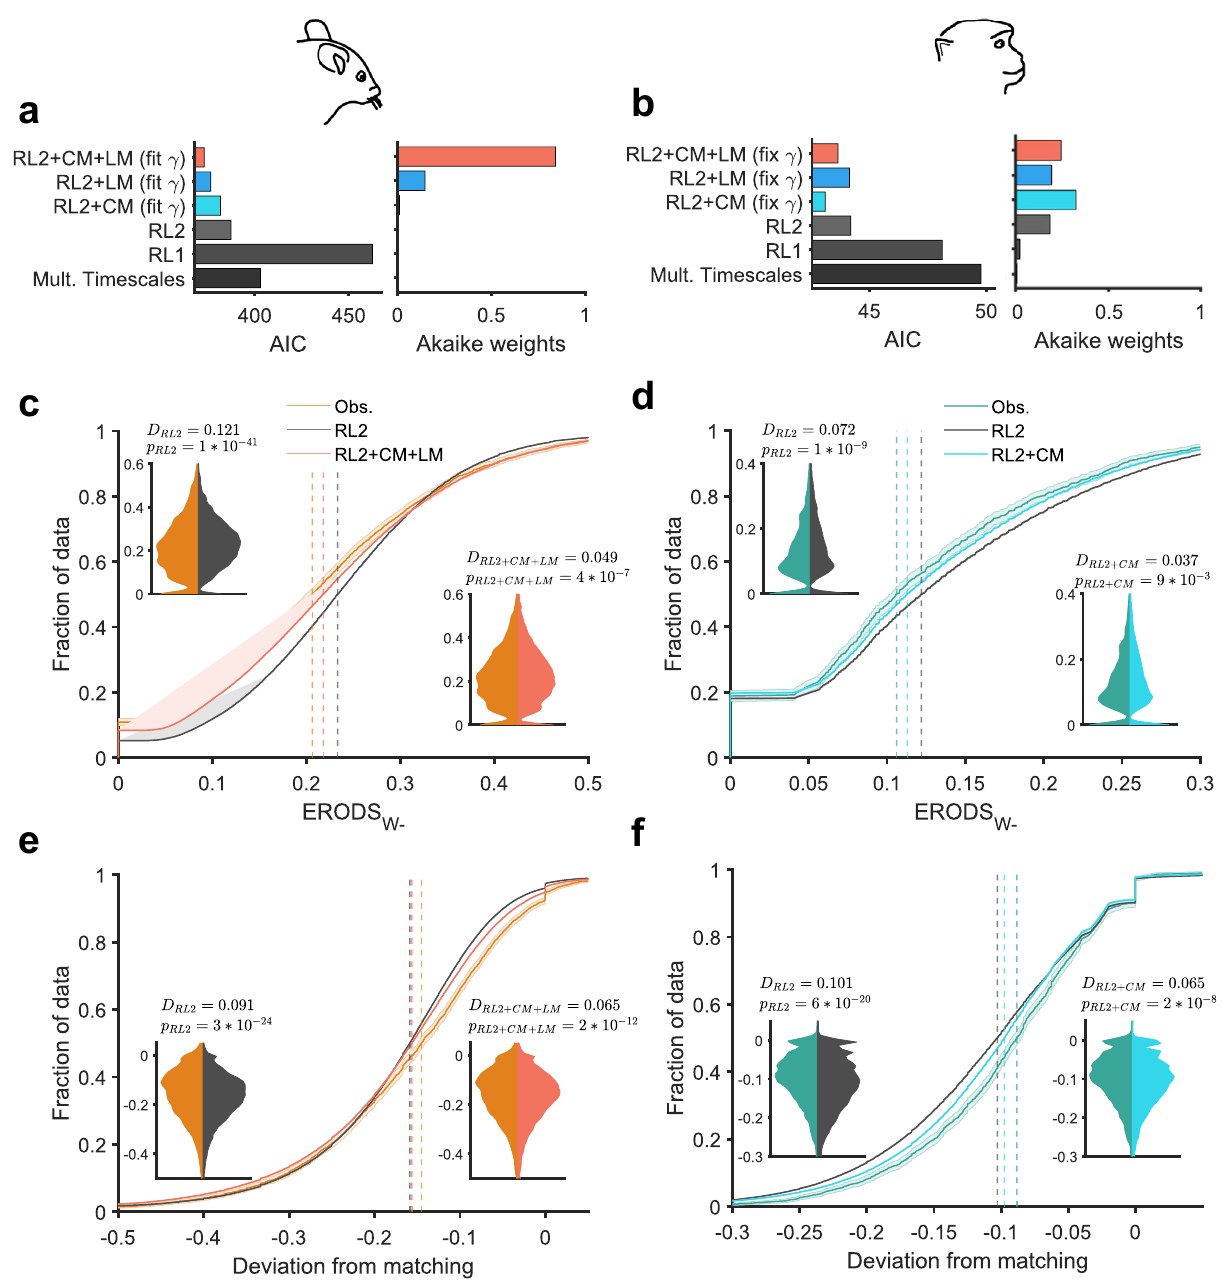
Fig. 5 RL2 + CM + LM and RL2 + CM models better account for choice behavior, undermatching, and entropy-based metrics in mice and monkeys, respectively. a , b Comparison of goodness-of- fi t of a return-based (RL1) model, income-based (RL2) model, income-based models augmented with choice memory (CM) and/or loss-memory (LM) components, and a model based on learning on multiple timescales. Plotted is the Akaike Information Criterion (AIC) averaged over all sessions and Akaike weights computed with the average AIC for mice ( a ) and monkeys ( b ). c – f Empirical cumulative distribution functions of ERODS W − ( c , d ) and deviation from matching ( e , f ) observed in animals and predicted from simulations of the RL2 and RL2 + CM + LM models. Shaded bars around CDFs indicate 95% con fi dence interval. Dashed vertical lines indicate the median of each distribution. Insets display the distribution of observed metrics versus metrics predicted using the RL2 model (left inset) and RL2 + CM + LM model and RL2 + CM model (right inset) for mice and monkeys, respectively. Displayed D -values and p values are the test-statistic and p value from a two-sided Kolmogorov – Smirnov test comparing the distributions. The RL2 + CM + LM model and RL2 + CM better captured deviation from matching by over 20% and over 30% in mice and monkeys,